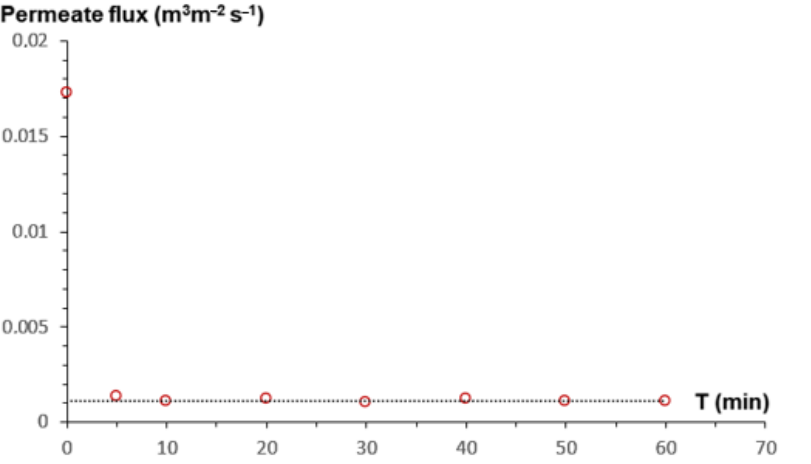
Figure 7. Changes in the permeate flux during the SAUF experiment.